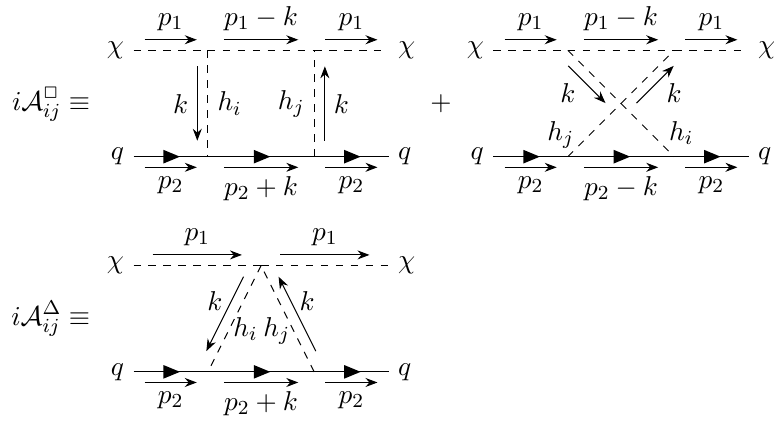
Figure 7 . Box topologies contributing to the DM-quark scattering referred to as A (cid:3) and the triangle topologies denoted by A ∆ . The indices i, j denote the Higgs mediators h 1 , h 2 .